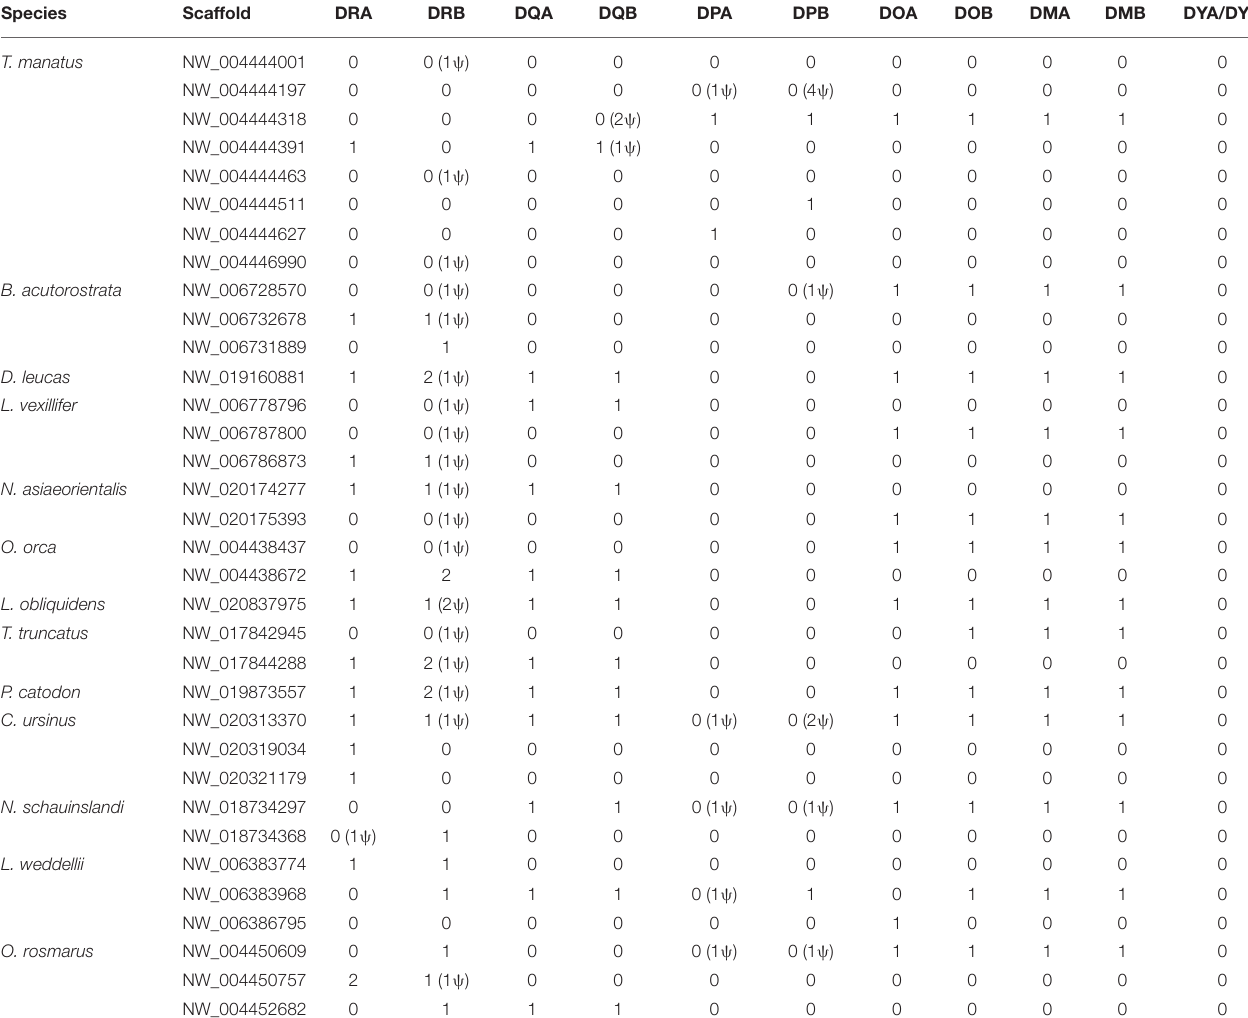
TABLE 1 | Number a of MHC class II genes and pseudogenes in each marine mammal scaffolds.